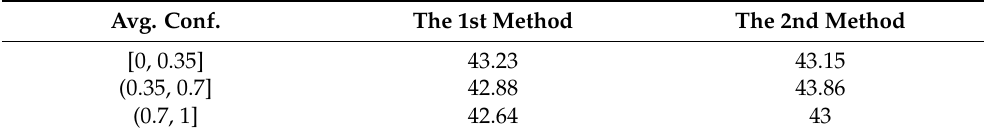
Table 2. Ablation study on OCRNet. Avg.